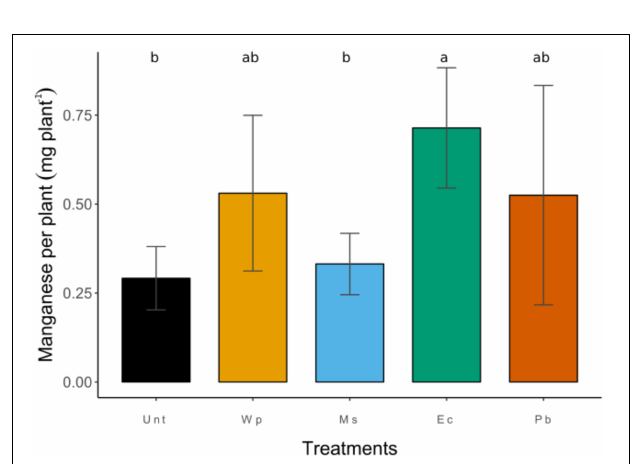
FIGURE 6 | Amounts of Mn phytoextracted by birch biomass depending on soil treatments. Values shown represent (means ± SD) the results of 12 replicates. Identical letters indicate no significant differences ( p < 0.05) across the